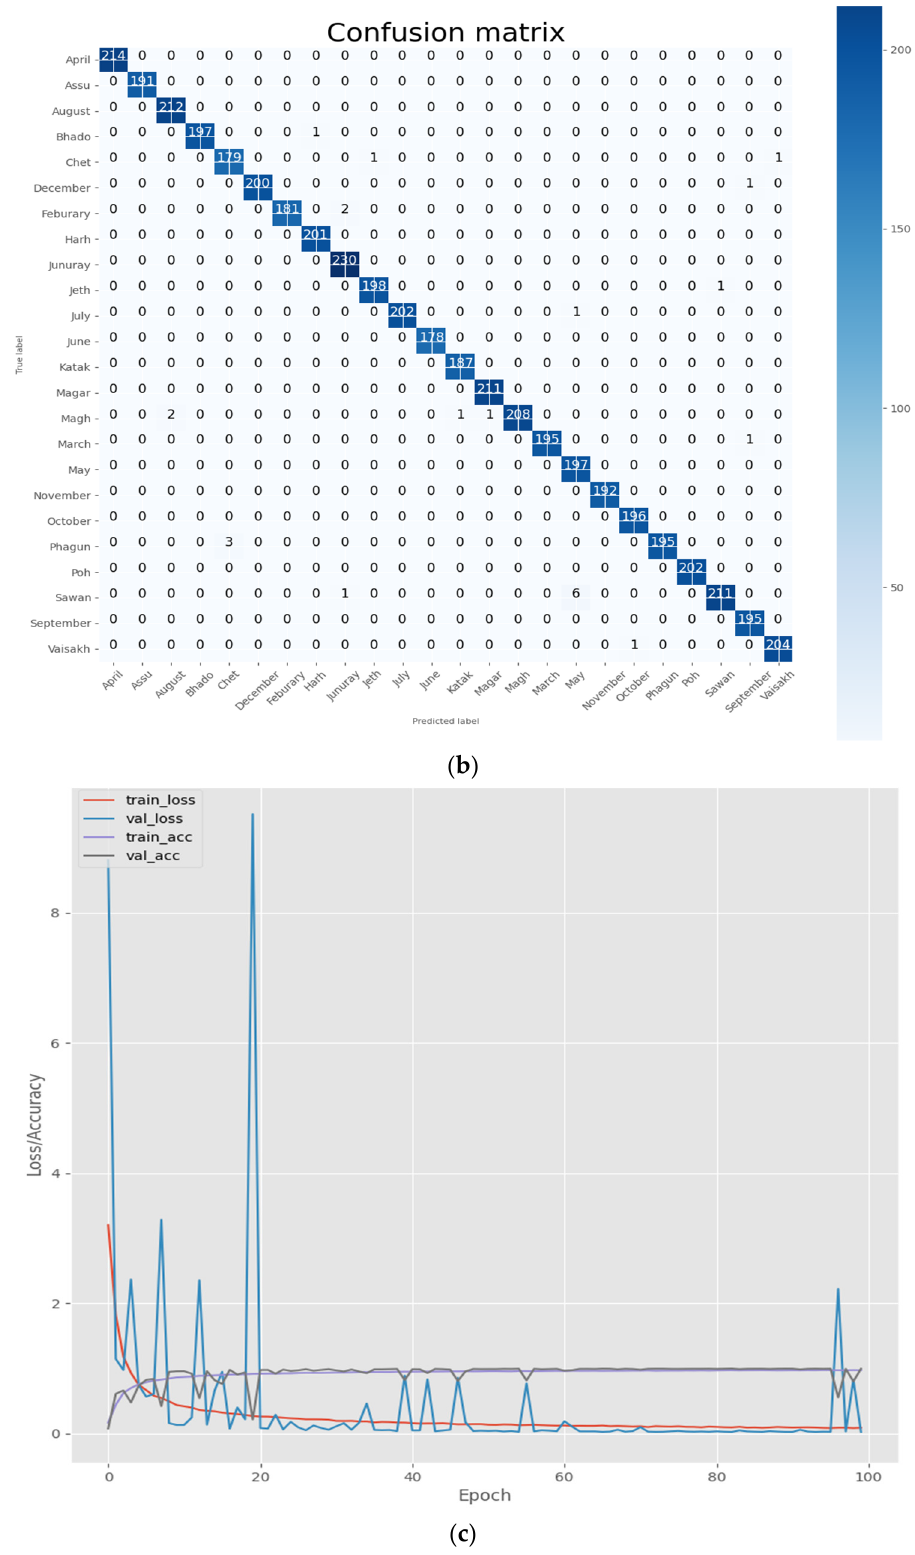
Figure 6. Analysis of the proposed model at 100 epochs and a batch size of 20: ( a ) precision, recall and F1 score of the 24 classes; ( b ) confusion matrix; ( c ) accuracy and loss curve.